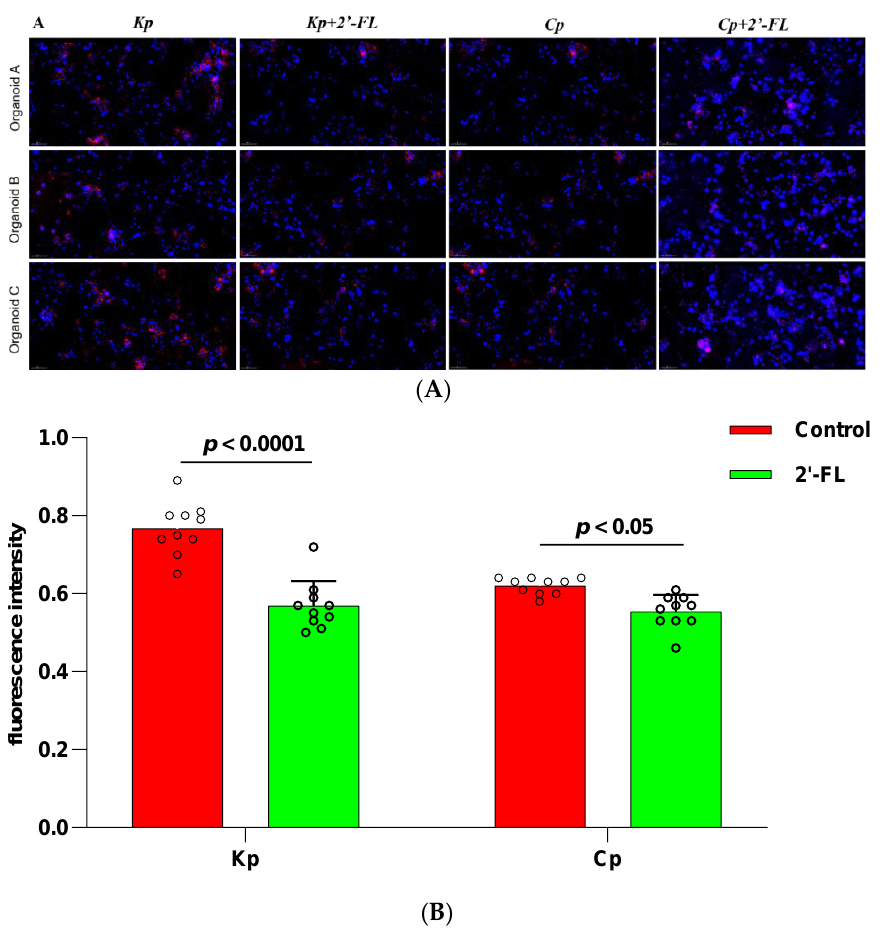
Figure 8. Analysis of the effects of 2′ -FL on Klebsiella pneumoniae and Clostridium perfringens adhesion to organoids in fluorescence detection images ( A ) and qFISH ( B ). The scale bar is 50 μm. Data were expressed as the mean ± SEM.